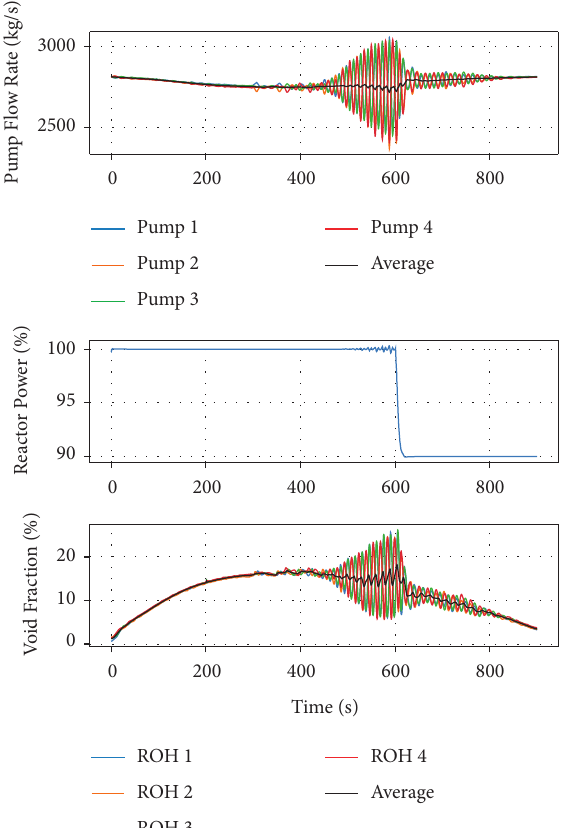
Figure 28: Flow oscillations at reduced pressure, with power reduced to 90% after 600 seconds. The even pair of pumps and headers oscillate out-of-phase with the odd